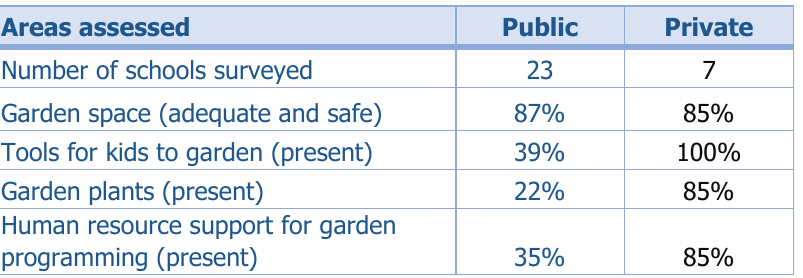
Table 1: San Mateo County School Garden Needs Assessment Results Areas